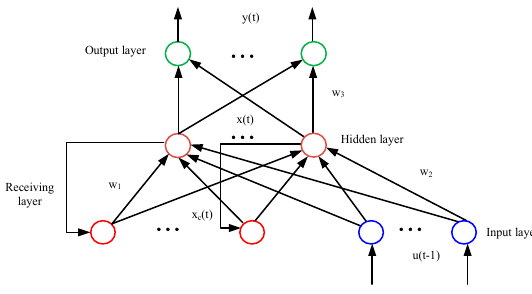
Figure 7. Schematic diagram of the Elman structure.